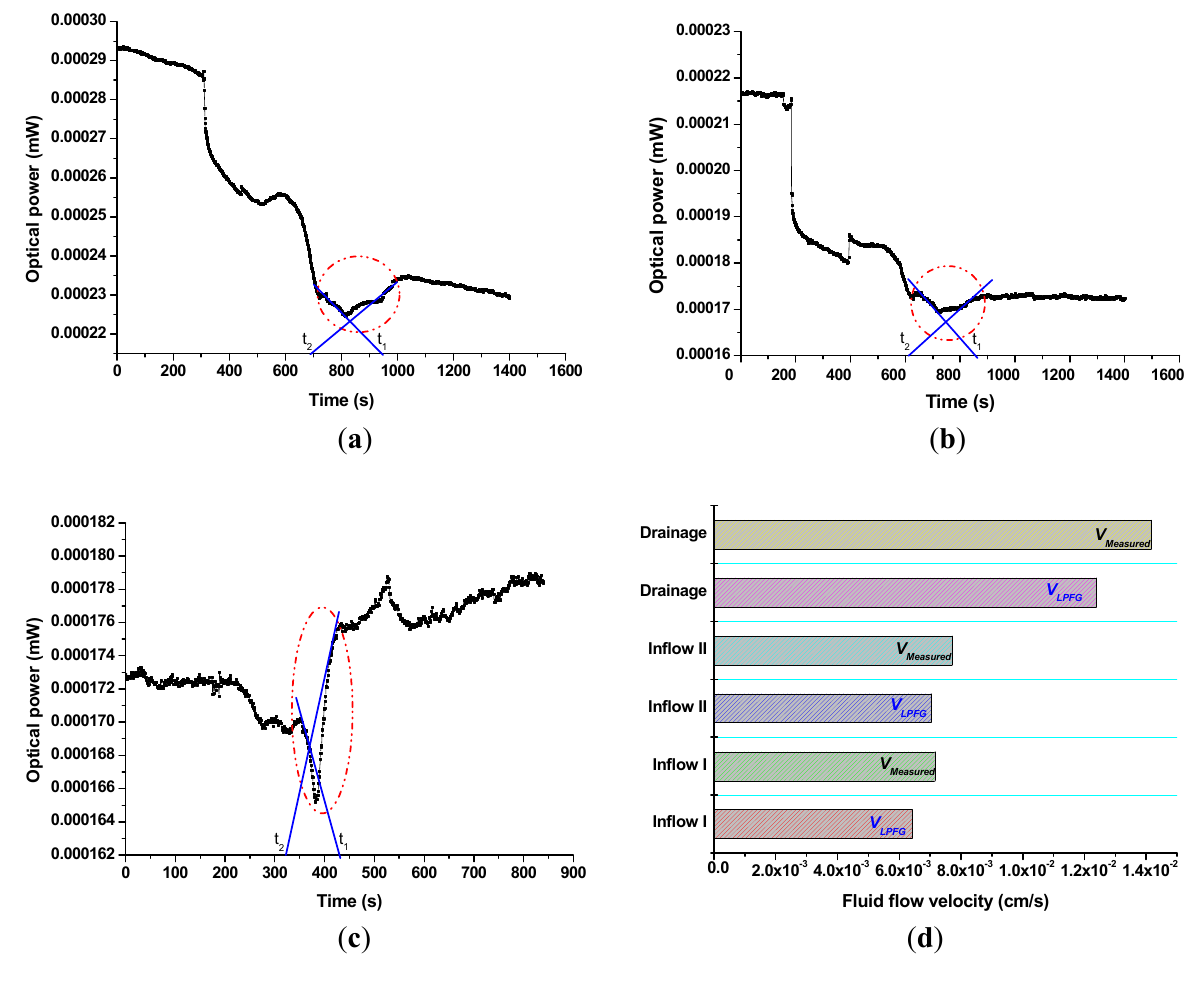
Figure 6. Plot of optical power versus time using LPFG No. 4 for fluid-flow velocity measurement: ( a ) Inflow I; ( b ) Inflow II; and ( c ) Drainage; ( d ) Comparison Plot of fluid-flow velocity for inflow and drainage